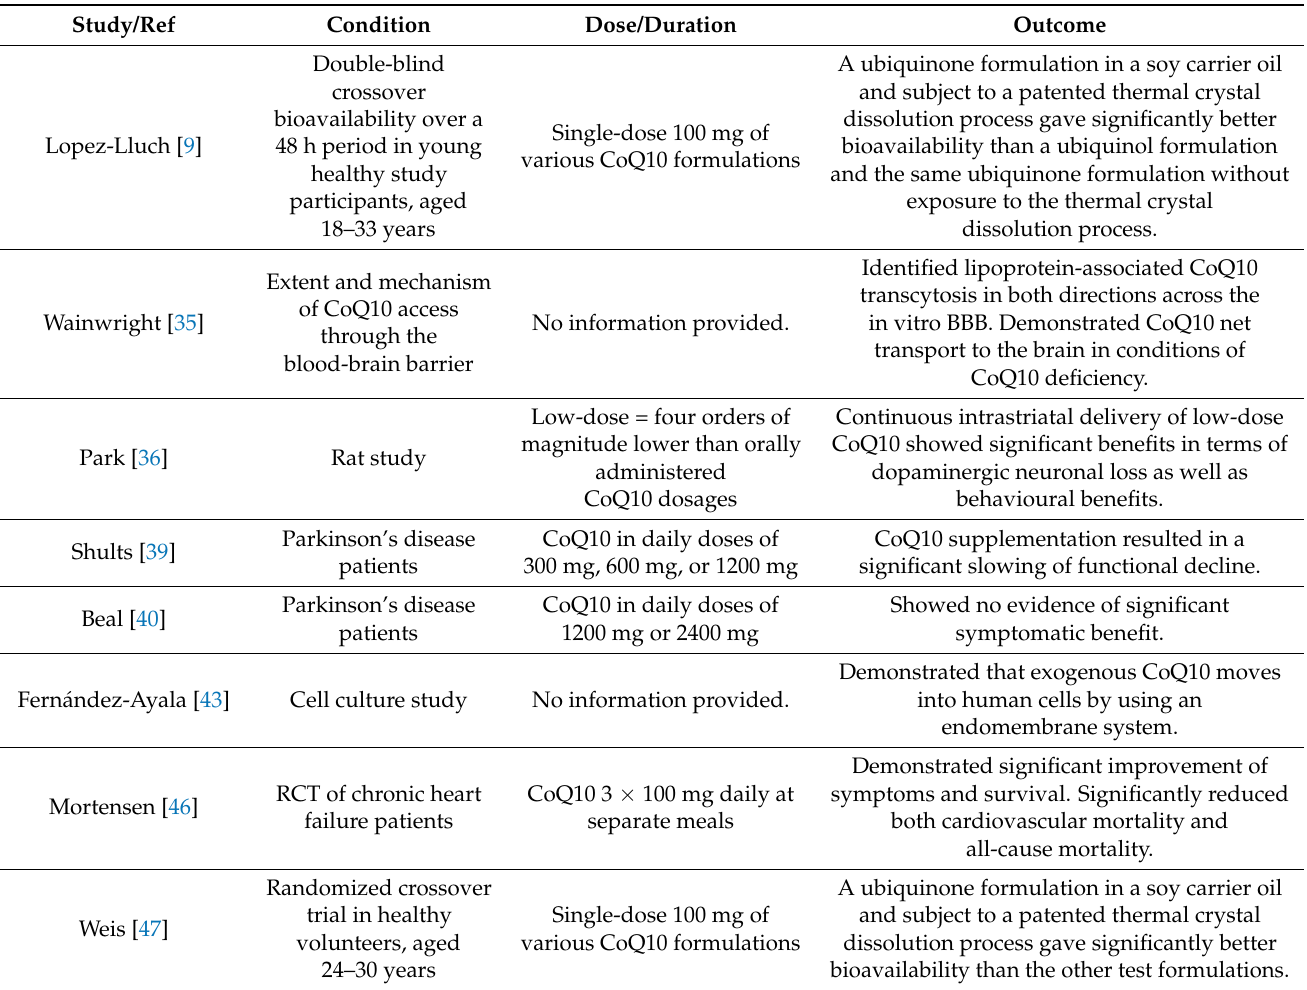
Table 1. Major pre-clinical and clinical trials referenced in the